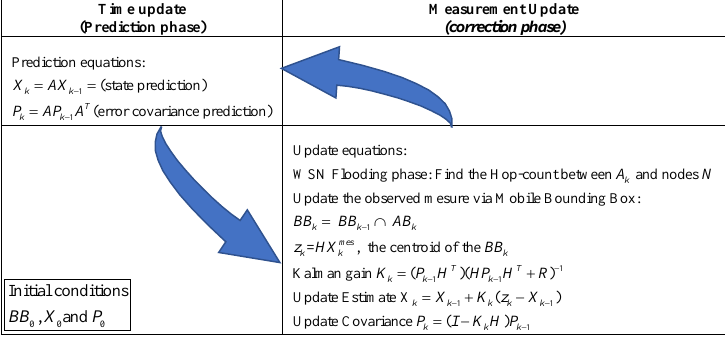
Figure 4. Proposed localization